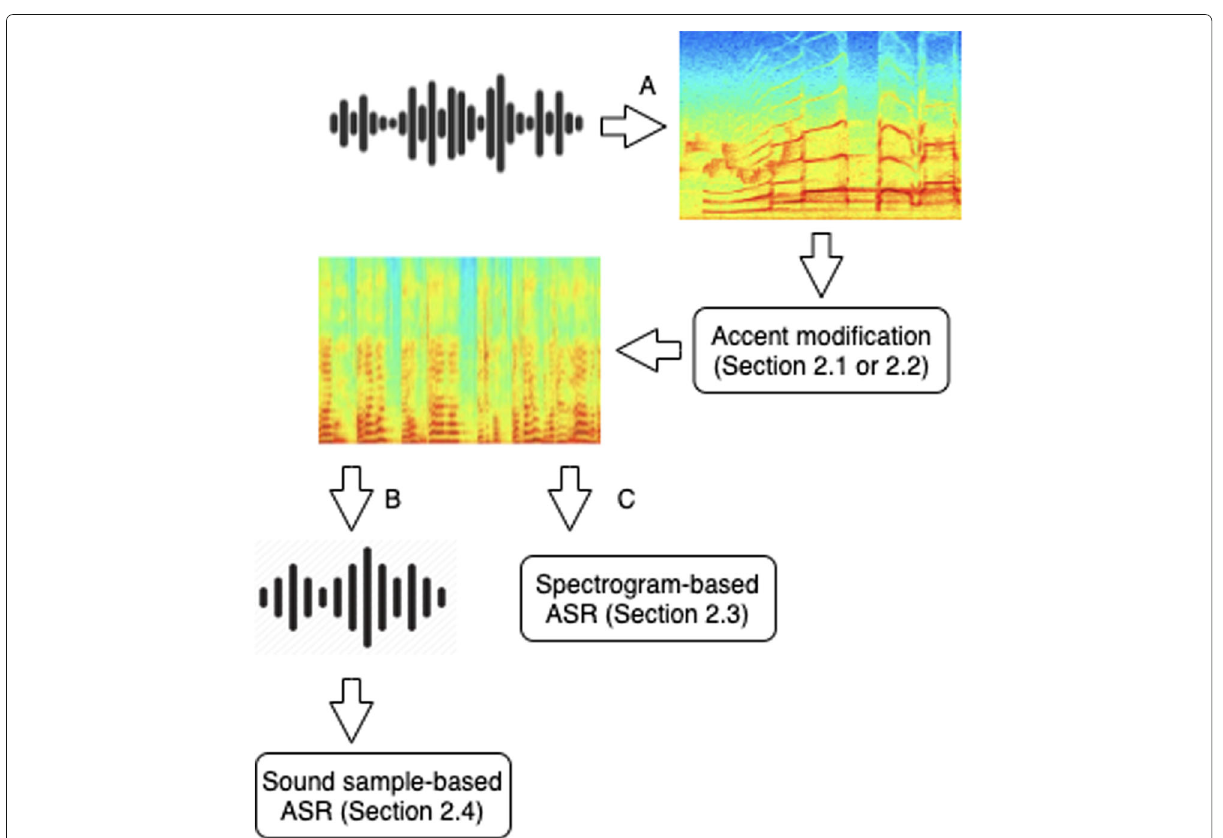
Fig. 1 Overall diagram of the solution. a Conversion from sound sample to a spectrogram, ( b ) conversion from spectrogram to a sound sample, and ( c ) spectrogram-based ASR